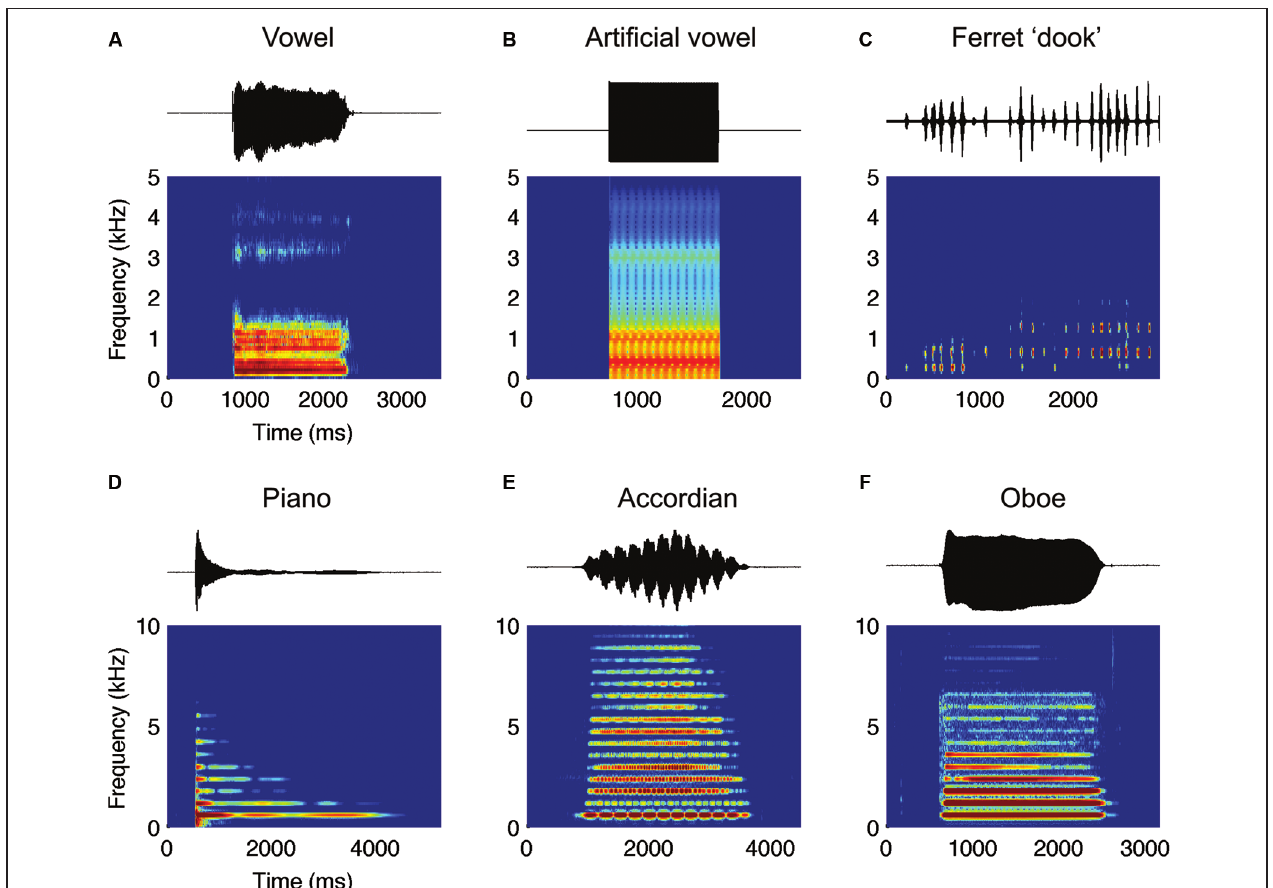
FIGURE 1 | (A) Amplitude waveforms (top) and spectrograms (bottom) for a female voice speaking “a” (as in “hard”) (B) an artificial “a” and (C) a male ferret making a series of “dook” calls. Such calls have a harmonic structure. (D–F) Amplitude waveform and spectrograms for (D) Piano, (E) Accordion